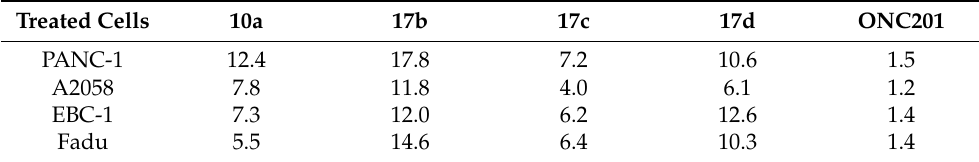
Table 2. IC 50 values ( µ M) of selected imipridone hybrids ( 10a , 17b , 17c and 17d ) and reference compound, ONC201, after 72 h of treatment, based on MTT assay. IC 50 values were determined by GraphPad Prism 8 software (nonlinear regression; variable slope; best-fit values; n = 4). Treated Cells 10a